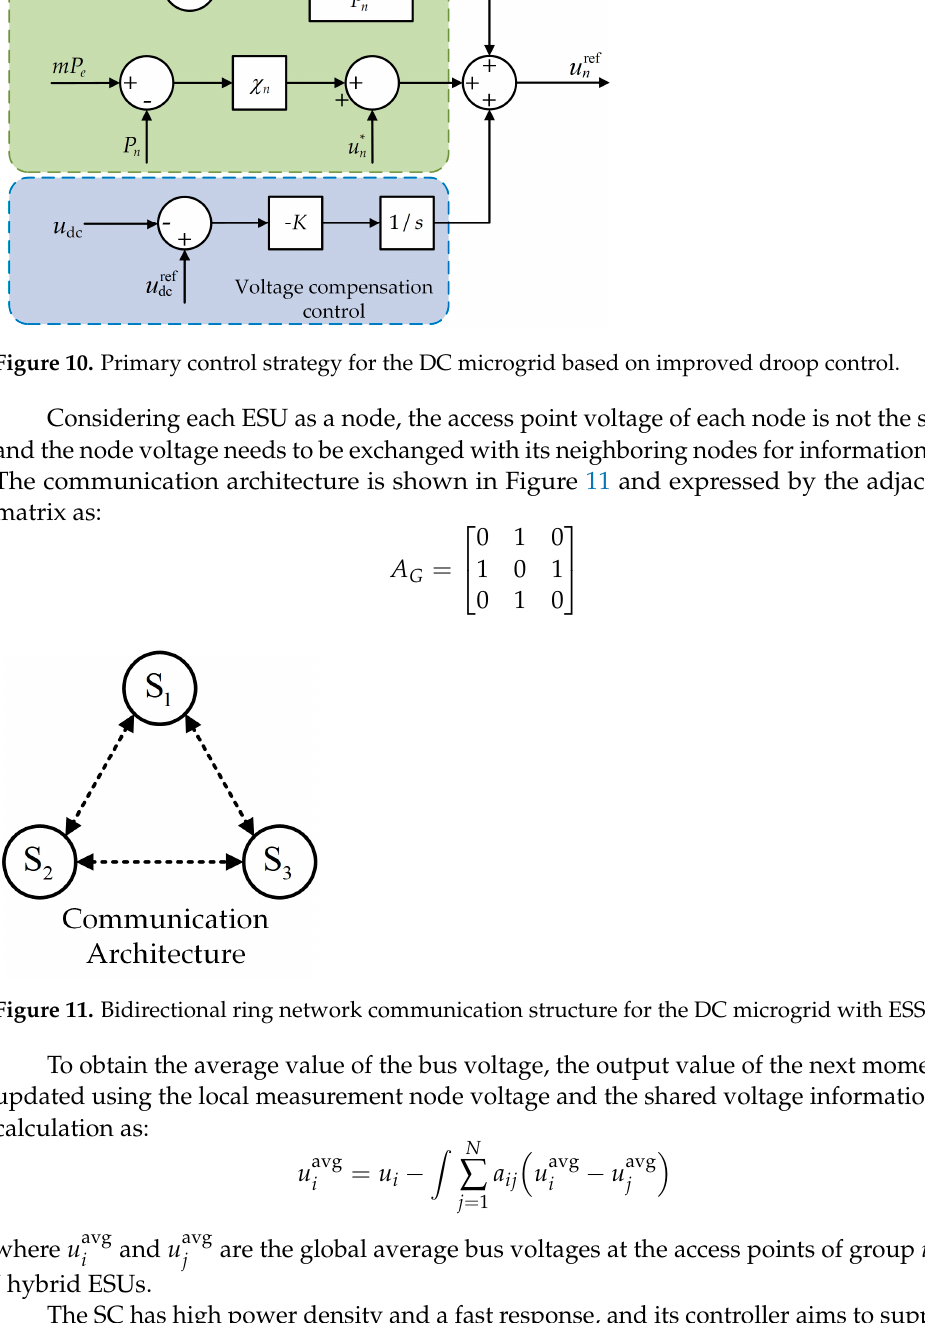
Figure 10. Primary control strategy for the DC microgrid based on improved droop control.